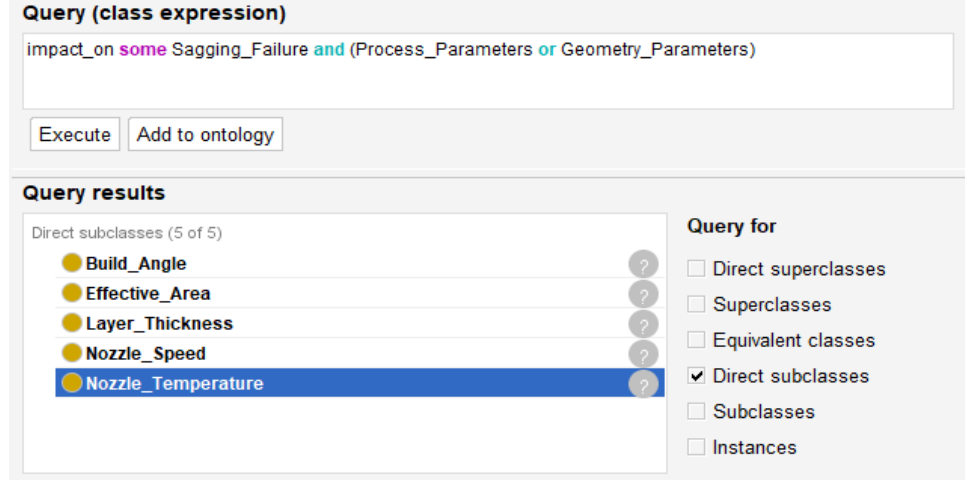
Figure 5. An example of search results by DL query in Protégé